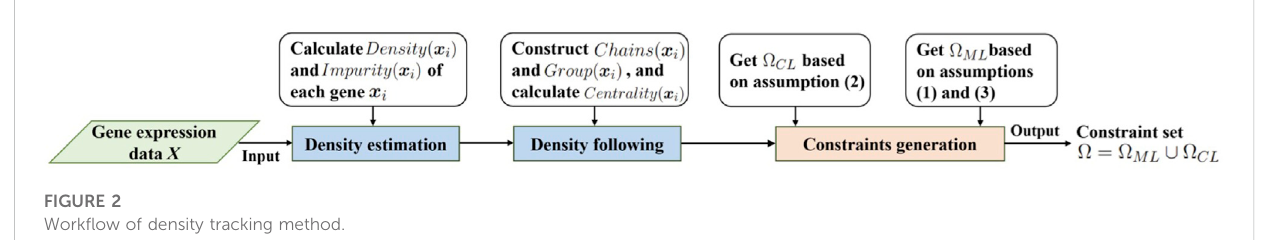
FIGURE 2 Work fl ow of density tracking